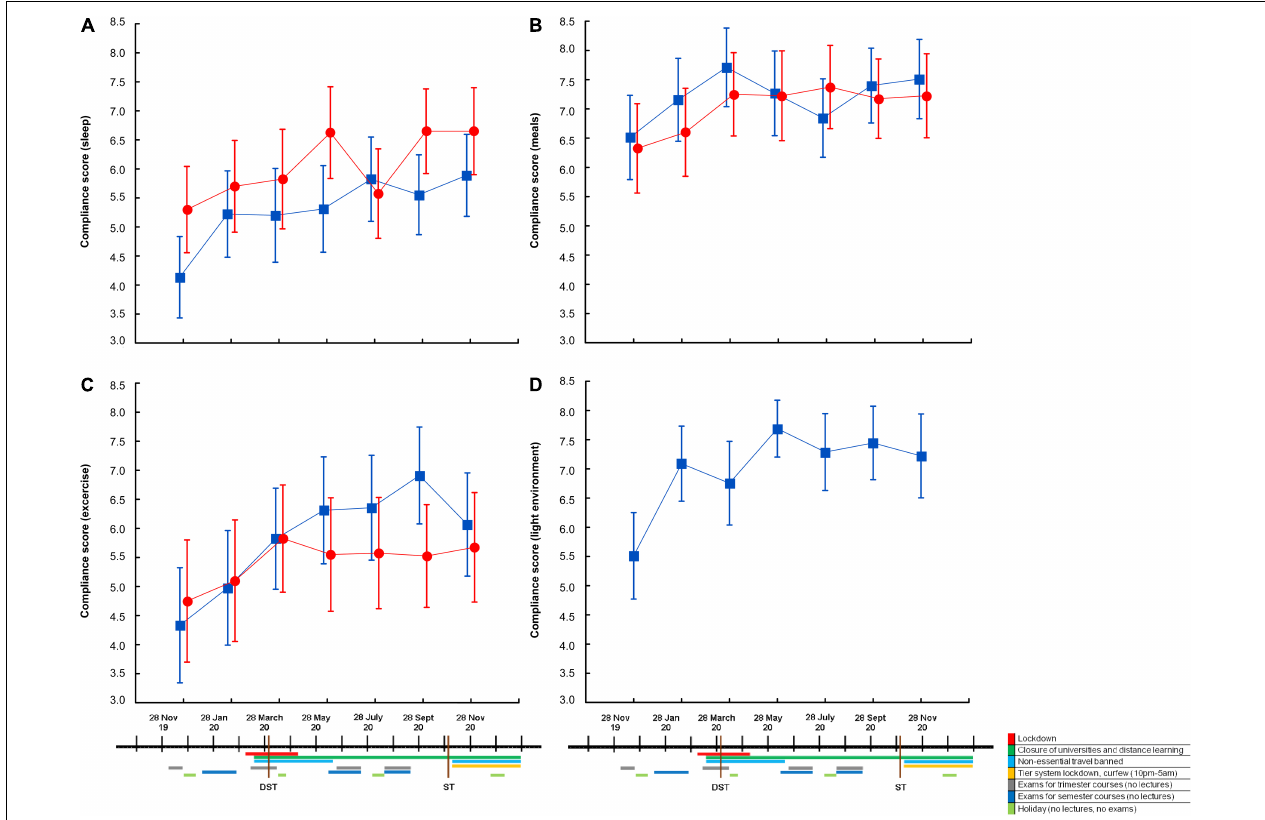
FIGURE 3 | Compliance to different types of advice by circadian hygiene education group, over time, and in relation to relevant 2020 events. Self-reported compliance to advice relating to sleep (A) , meals (B) , exercise (C) , and light environment (D) in the “A regular life” (red circles; n = 40 at each time point) and the “Bright days and dark nights” (blue squares; n = 45 at each time point) groups. Significant differences between the two groups were observed in compliance to sleep advice (A) , which was greater in the “A regular life” group [ F ( 6 , 498 ) = 6.0, p time < 0.0001, F ( 1 , 83 ) = 4.1, p group = 0.045, F ( 6 , 498 ) = 1.6, p interaction n.s.]. Compliance to all types of advice increased over time in both groups ( p time always significant, with no further differences between groups and no interactions). Values are expressed as means ± 95% confidence intervals. n.s., not statistically significant.